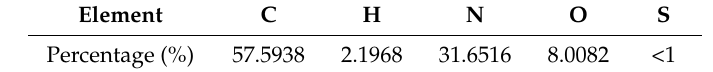
Table 1. CHNOS elemental analysis of OGCN.